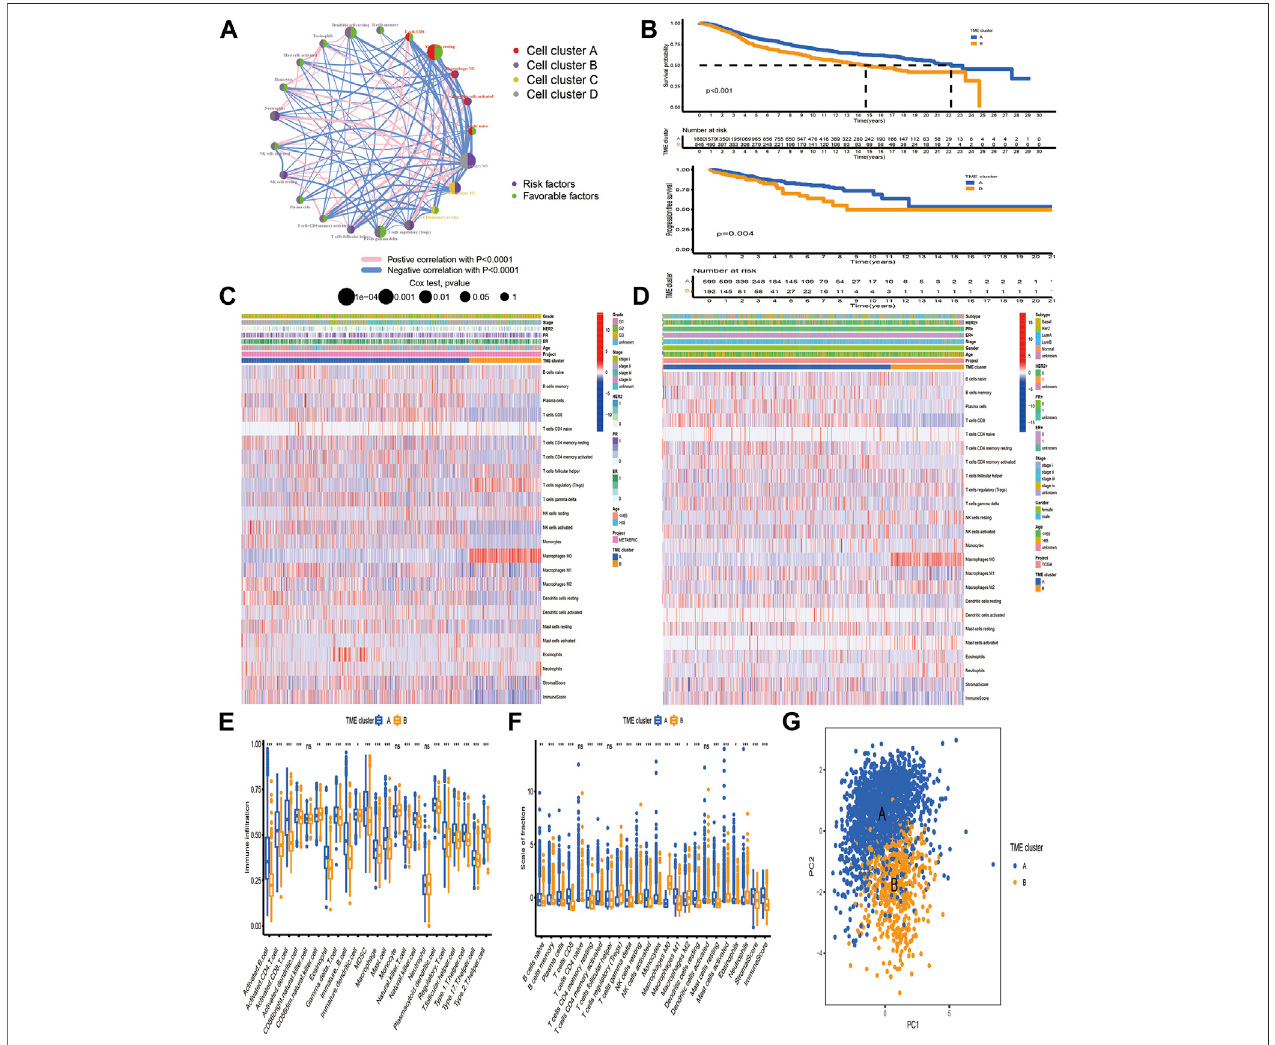
FIGURE 1 | Tumor microenvironment-mediated pattern clusters in breast cancer. (A) The interaction between TME-in fi ltrating immune cells in BC. The lines connecting immune cells represented their interaction with each other. The size of each circle represented the prognostic effect of each immune cell and scaled by p -value. Protective factors for patients ’ survival were indicated by a green dot in the circle center and risk factors indicated by the purple dot in the circle center. (B) Kaplan – Meier curves of OS and PFS for BC patients in the meta-cohort and TCGA-BRCA dataset with distinct TME clusters. The numbers of patients in TME cluster A and B were 1,682 and 545, respectively. (C,D) Unsupervised clustering of immune cells in the TCGA-BRCA and METABRIC datasets. Clinicopathological information, including age, gender, ER, PR, HER2, molecular subtype, stage, grade and TME cluster were used as patient annotations. Red represented the high expression of immune cells, and blue represented the low expression of immune cells. (E, F) The fraction of tumor-in fi ltrating lymphocytes in distinct TME clusters using the ssGSEA and CIBERSORT algorithms. Within each group, the scattered dots represented TME cell expression values. The thick line represented the median value. The bottom and top of the boxes were the 25th and 75th percentiles (interquartile range). The statistical difference of two TME clusters was compared through the Kruskal – Wallis H test. * p < 0.05; ** p < 0.01; *** p < 0.001. (G) PCA of TME-in fi ltrating immune cells to distinguish TME cluster A from